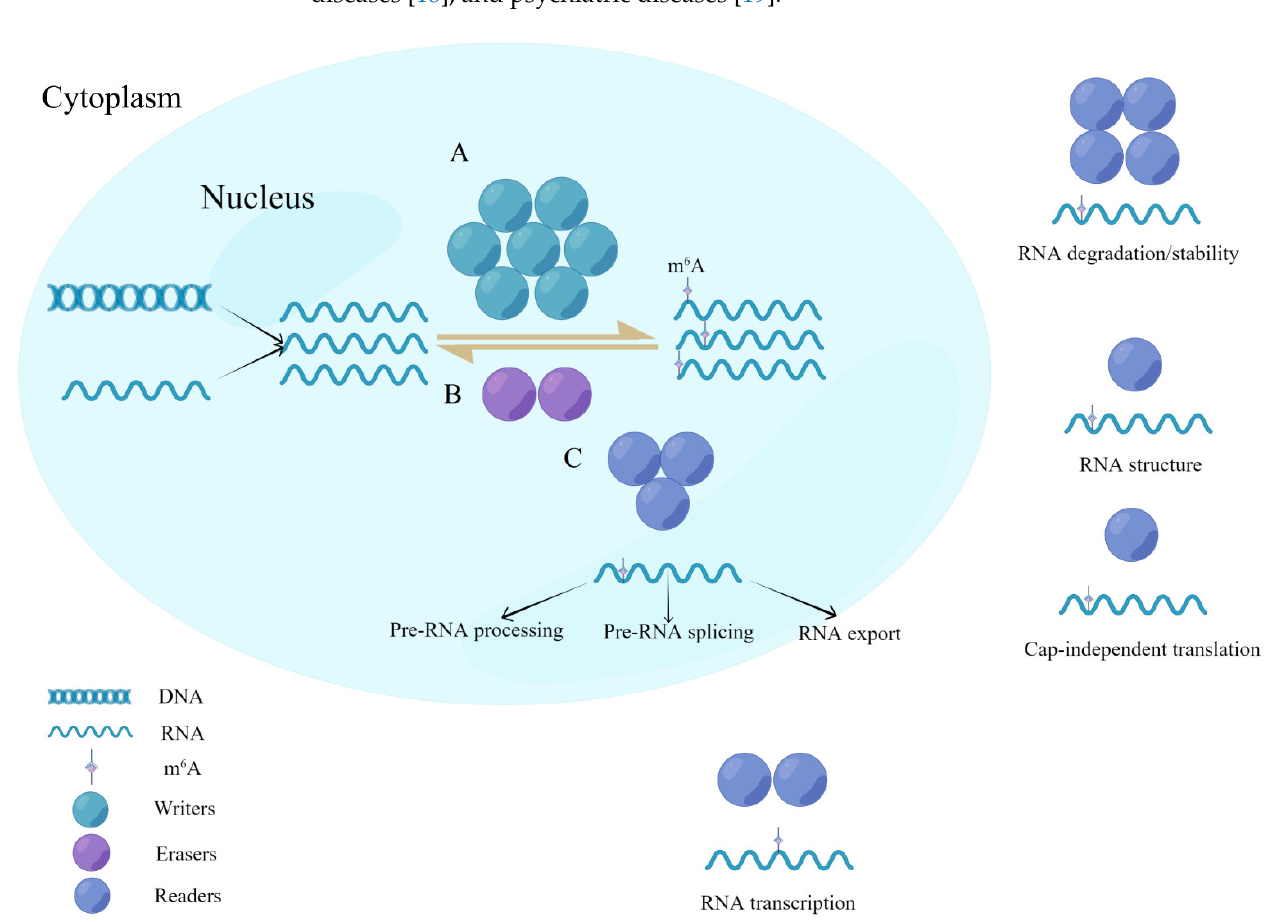
Figure 1. Dynamic reversible process for writers, readers, and erasers in m 6 A modifications. ( A ) Methyltransferases (writers) are a class of catalytic enzymes that catalyze m 6 A methylation modification of bases in substrate RNA by forming a complex. ( B ) Demethylases (erasers) have the opposite function of writers and are capable of demethylating RNA in the nucleus. ( C ) Methylated reading proteins (readers) are specific RNA-binding proteins that undergo m 6 A modifications to produce specific biological functions.